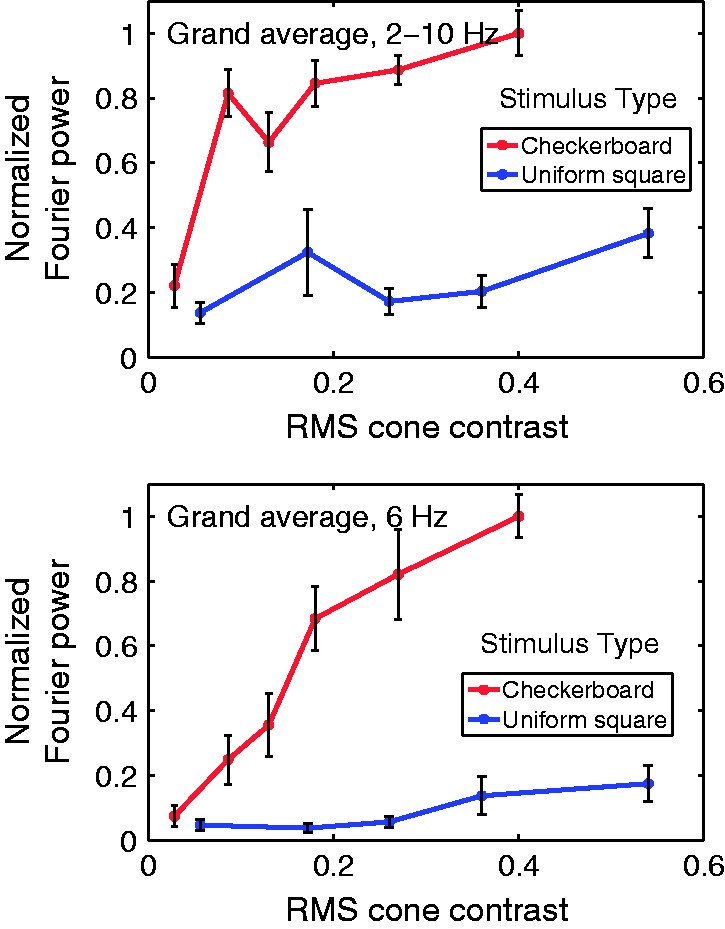
Normalized Fourier power averaged over all participants and plotted as a function
of RMS cone contrast for the checkerboard (red) and uniform-square (blue) stimuli.
In the top graph, the Fourier power for each participant was summed over the first
five Fourier harmonics (2 to 10 Hz) before normalization and grand averaging. The
lower graph shows normalized Fourier power calculated for only the third harmonic
(corresponding to 6 Hz) before normalization and grand averaging. Note that the
error bars represent ±1 SEM.